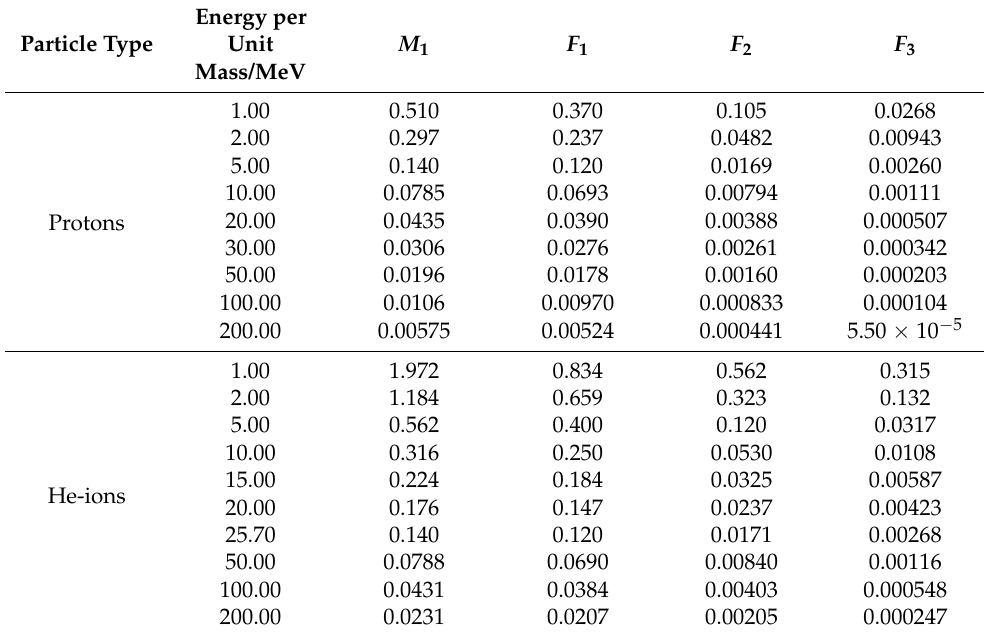
Table A1. Nanodosimetric quantities for protons, helium and carbon ions in a sphere of D = 1 nm.